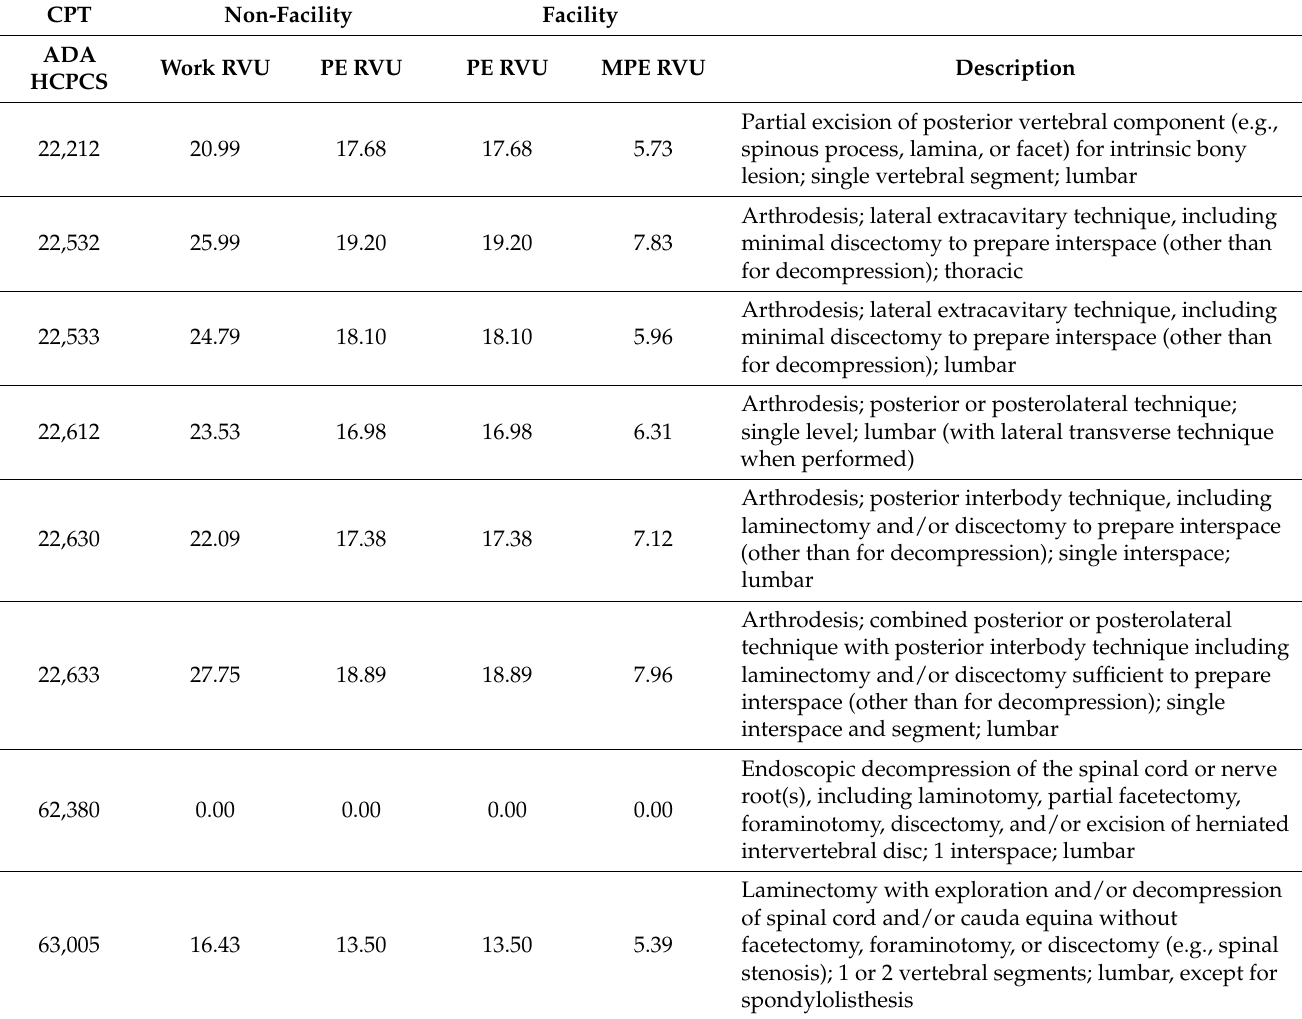
Table 1. CPT ® codes representative of 2018 wRVUs cited from the Medicare fee schedule.